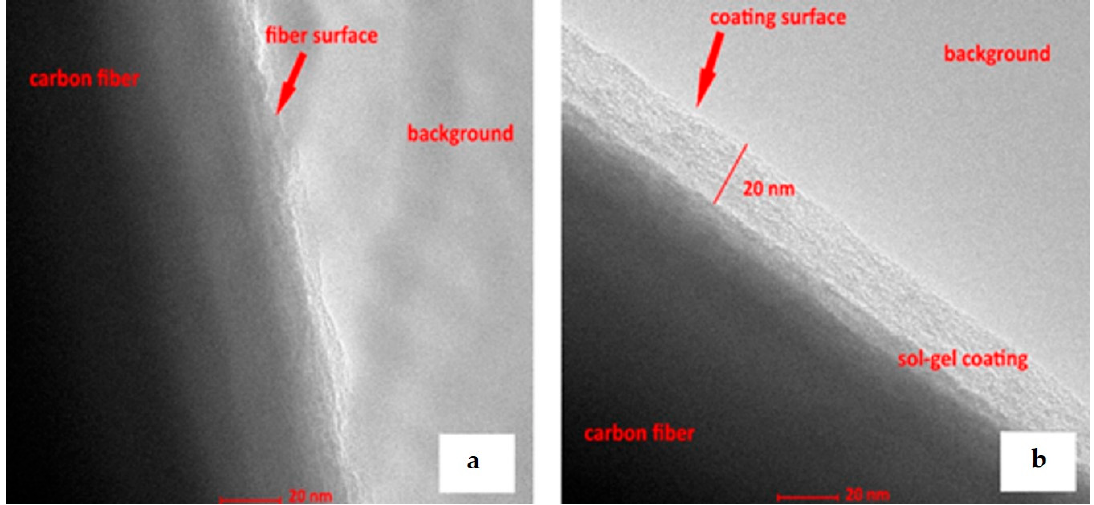
Figure 9. TEM images of: ( a ) uncoated carbon fibre, ( b ) carbon fibre with silica coating.